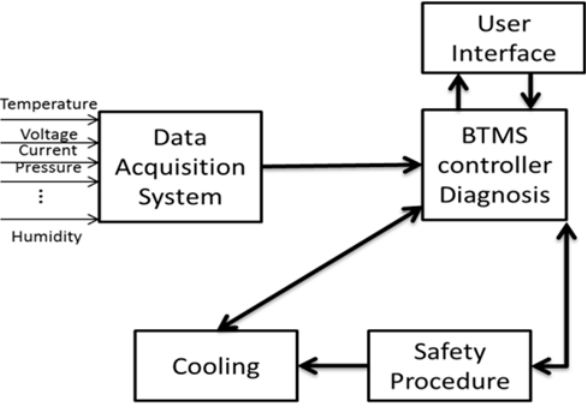
Figure 3. A generic view of the composition of BTMSs [37].